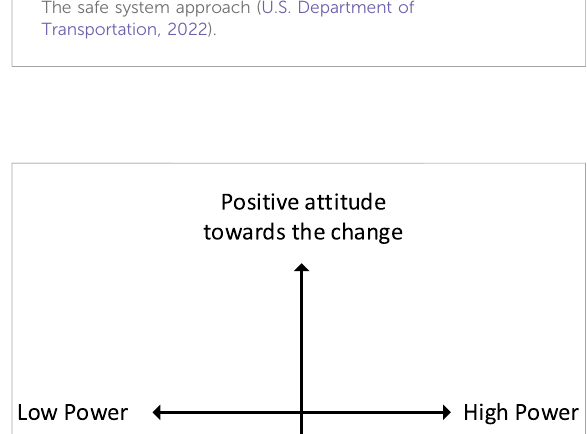
FIGURE 1 The safe system approach (U.S. Department of Transportation, 2022).